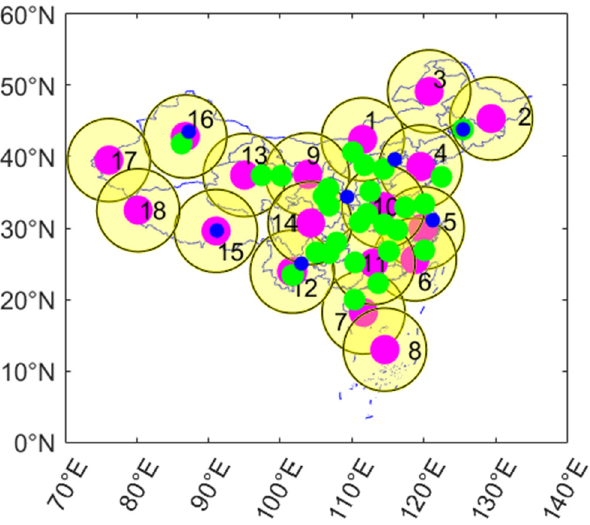
Figure 1. Chinese Beidou navigation system (BDS) satellite-based augmentation services (SBAS) partitions and distribution of precise point positioning (PPP) stations. The coverage of each partition is represented by a circle with radius of 800 km, where the partition center is plotted in pink dot. Blue dots are International GNSS Monitoring and Assessment System (iGMAS) sites and Crustal Motion Observation Network of China (CMONOC) sites are in